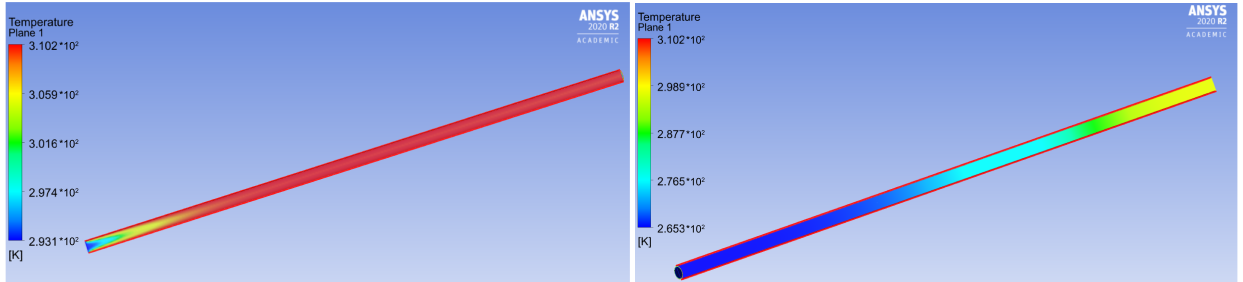
Figure 16. Temperature distribution in the catheter with a non-Newtonian ( left ) and Newtonian (cid:114) ( right ) model of Squid-12